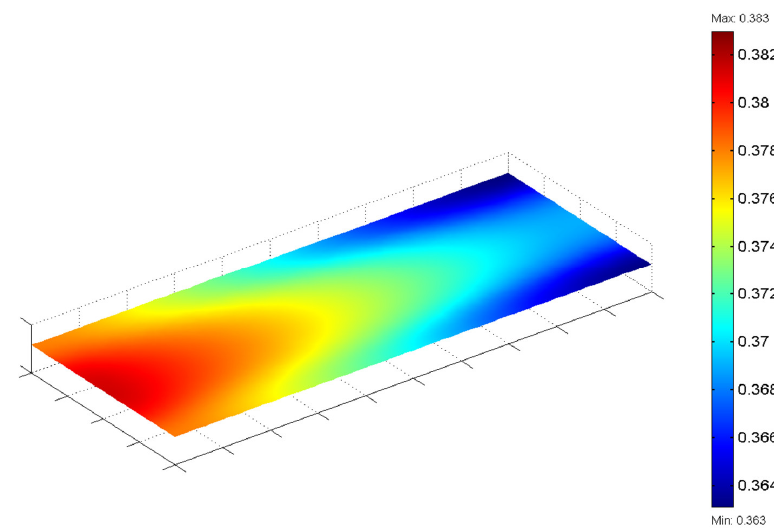
Figure 16. Variation of activation overpotential at the CCL at peak power.